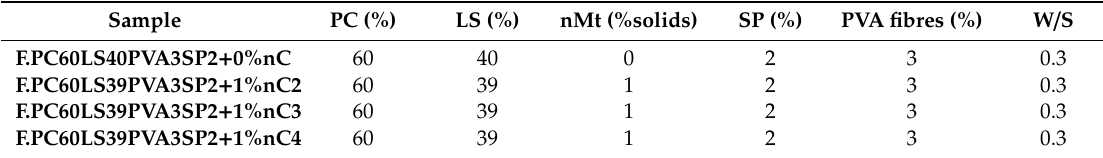
Table 2. Composition of ternary fiber cement nanohybrids—proportions % by total mass of solids. Sample PC